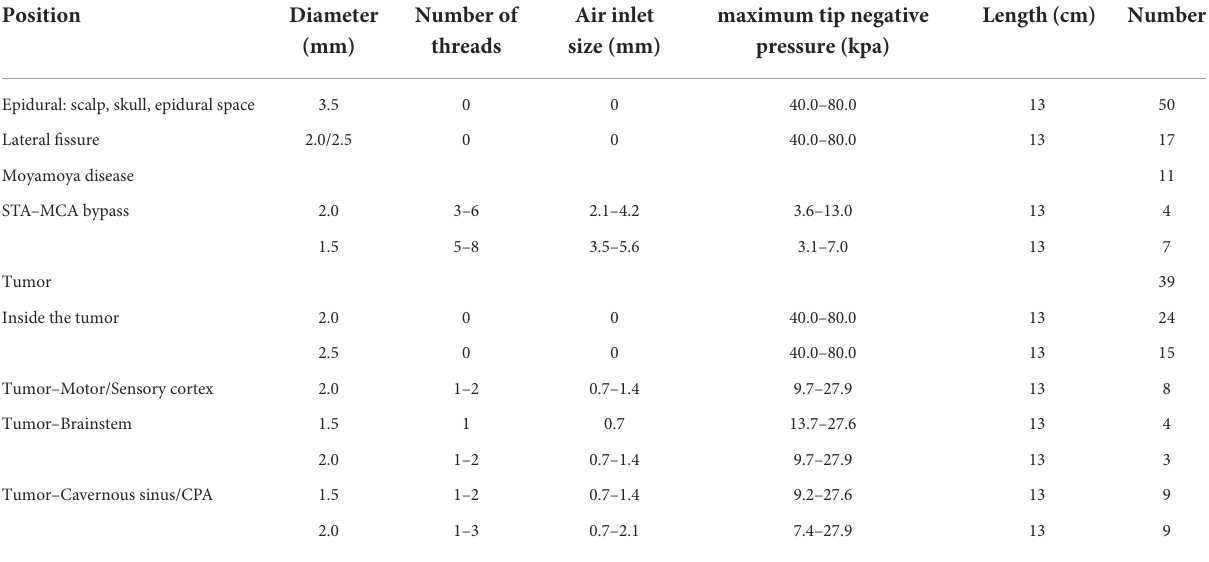
TABLE 4 Intraoperative real-time recording of